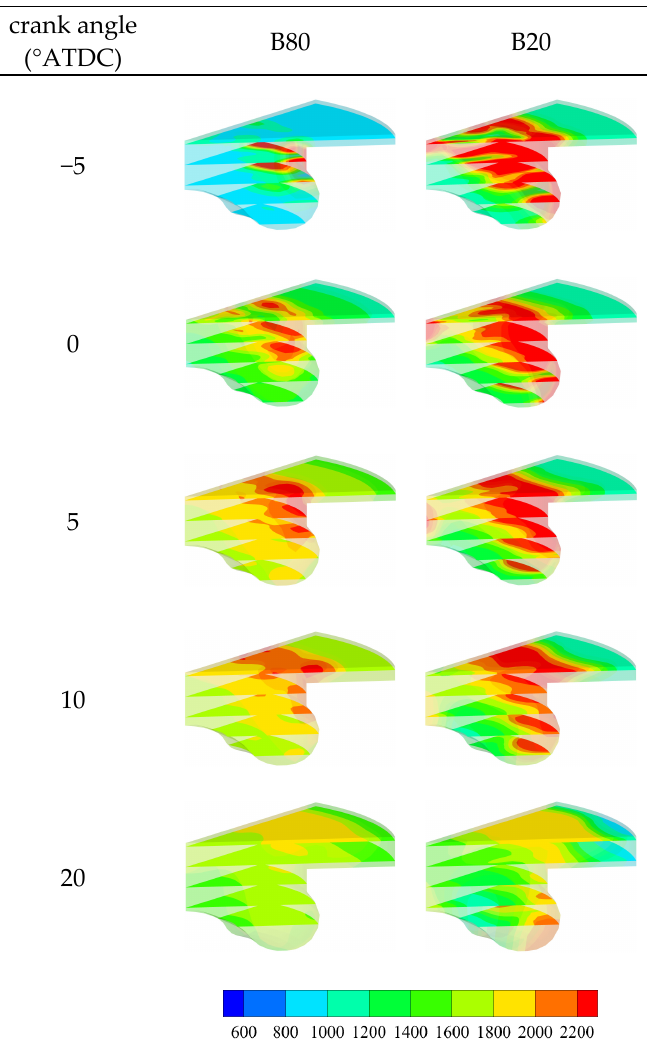
Figure 11. Simulated evolution of spatial temperature (K) distributions under conditions of B20 and B80.